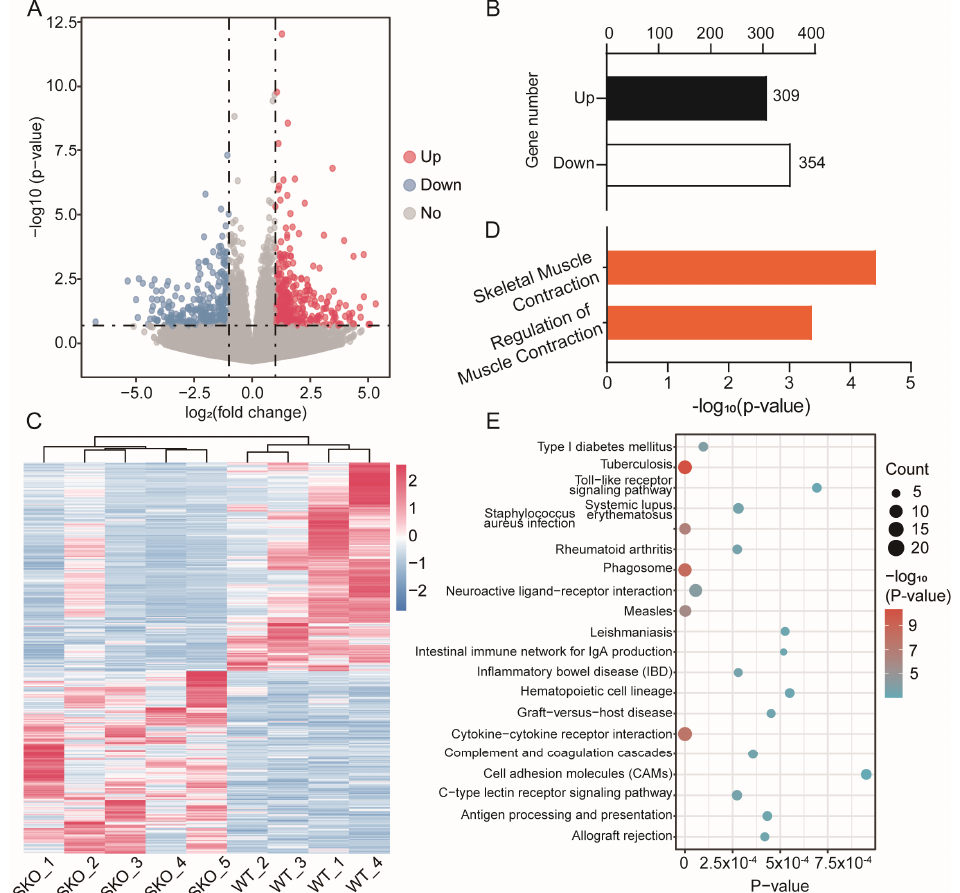
Figure 6. Statistical analysis of the expressed genes. ( A ) The volcano plot of all DEGs between muscle of Zbed6 +/ − and WT mice. Red spots represent upregulated DEGs, and blue spots represent downregulated DEGs. The gray spots indicate genes with no significant difference in expression. The horizonal black dotted line shows that the p value is equal to 0.05, while the vertical dotted line shows that log2FC is equal to − 1 (left) or more than 1 (right). ( B ) Statistics of up- and down-regulating DEGs. ( C ) Hierarchical clustering of DEGs. Red indicates upregulated DEGs, and blue indicates upregulated DEGs. The darker the color is, the more changes in gene expression there are. ( D ) Significantly enriched Gene Ontology terms of DEGs using p value equal to 0.05 as threshold. ( E ) Top 20 KEGG pathways of DEGs.